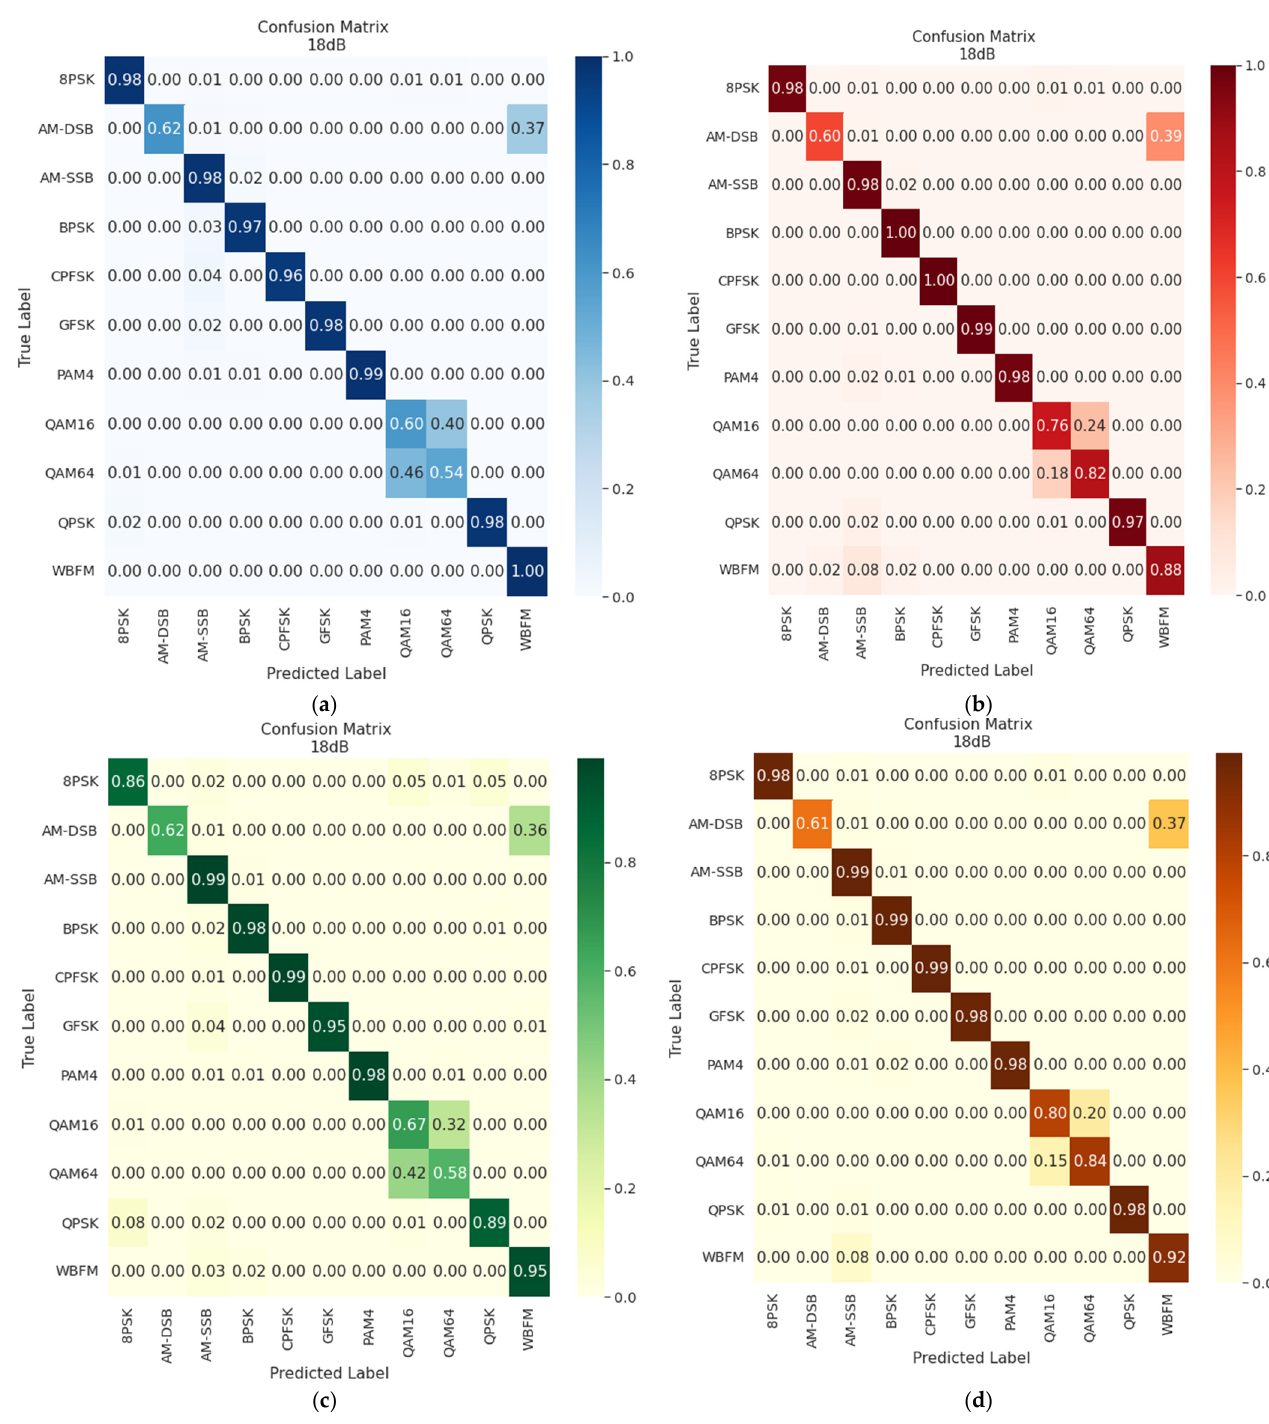
Figure 21. Confusion matrices at SNR 18 dB for ( a ) CNN 1D; ( b ) CNN + LSTM; ( c ) CNN 2D; ( d ) biLSTM.